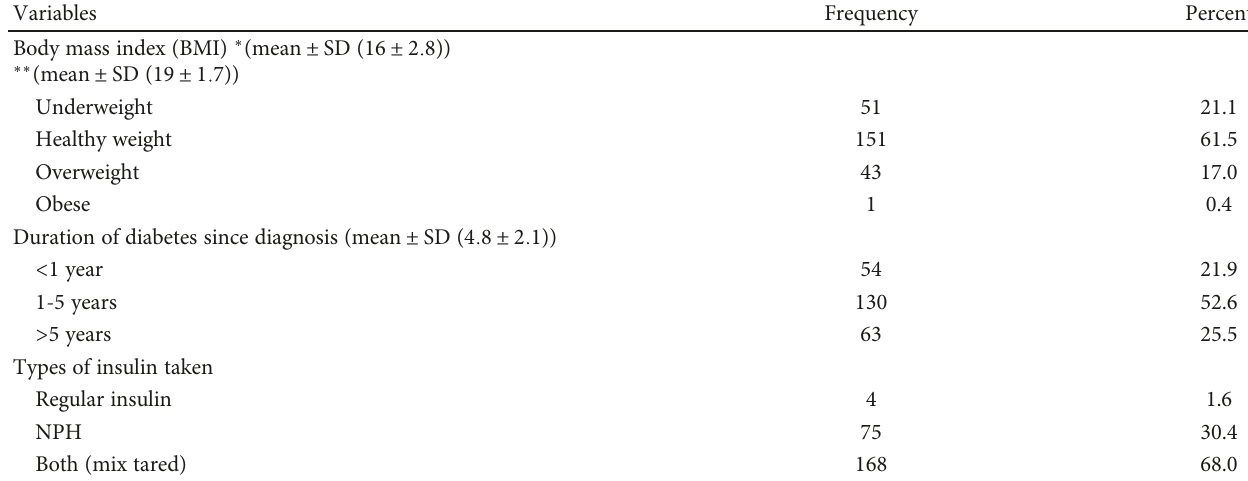
Table 2: Clinical characteristics of ambulatory T1DM patients attending the diabetes clinics of SPHMMC from June 01 to August 01, 2018. Variables